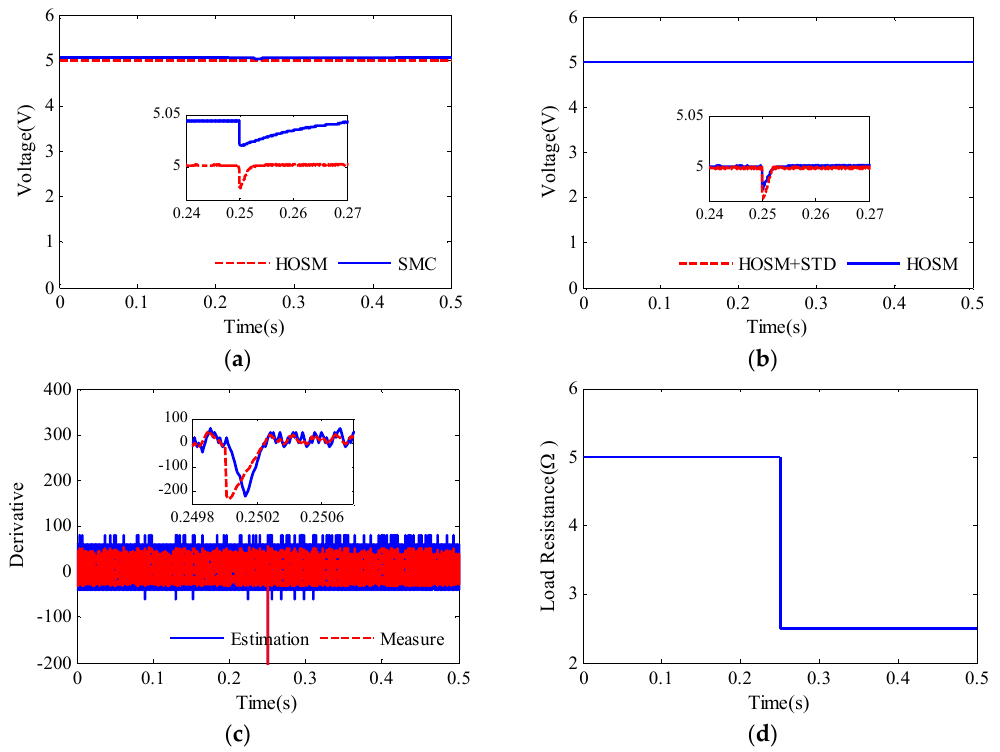
Figure 4. Simulation results for the buck converter under the disturbance in load resistance (step change from 5 to 2.5 Ω at 0.25 s), β = 70.2, k = 85. ( a ) Output voltage comparison between HOSM and SMC; ( b ) Output voltage comparison between HOSM + STD and HOSM; ( c ) Comparison between the measured and estimated derivative of the sliding mode variable d σ /d t ; ( d ) The load resistance.